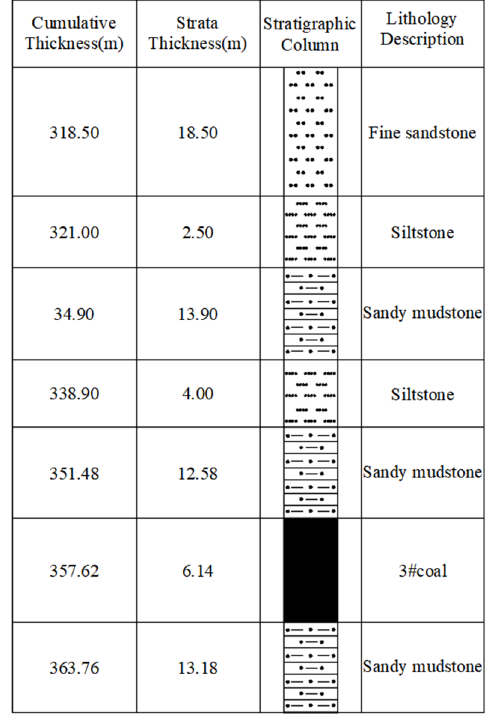
Figure 1. Strata histogram of 4309 working face.